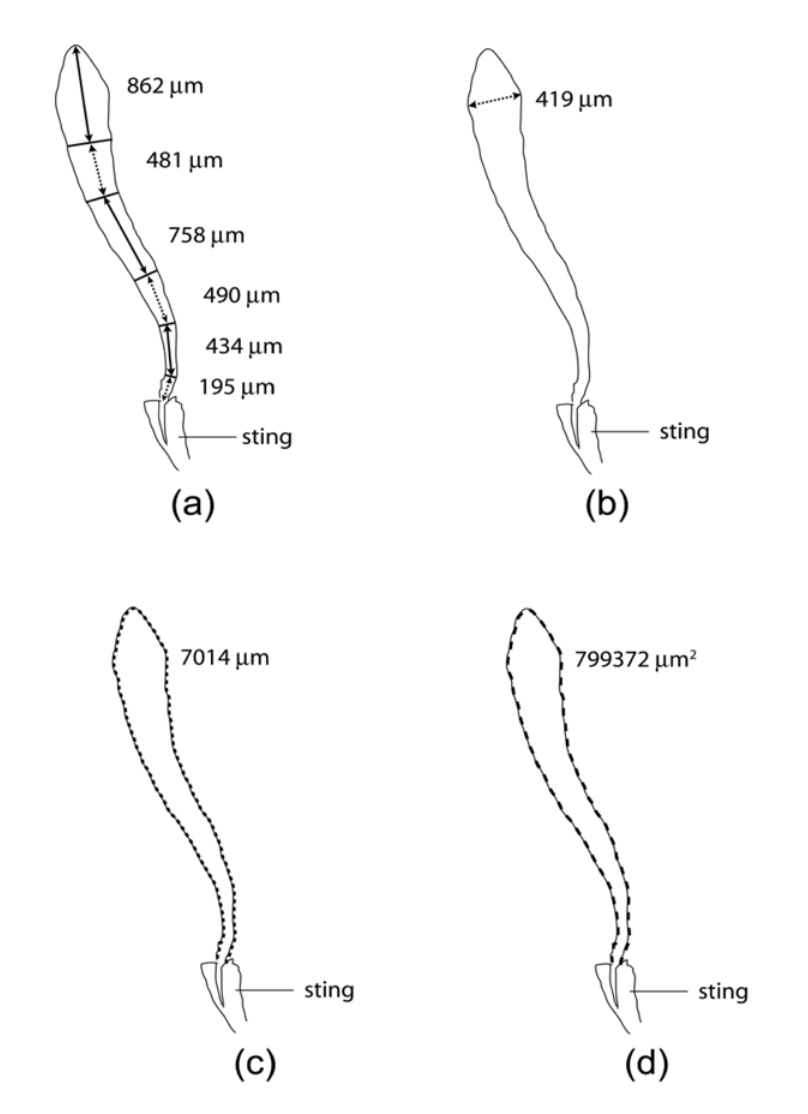
Fig 1: Diagrammatic representation of the measurements made from the image of Dufour’s gland of Ropalidia marginata ; (a): length of the gland (breaking up the length into several short straight-line segments and summing them up), (b): maximum width of the gland, (c): perimeter of the gland’s image, and (d): area covered by the gland’s image. (Diagram made by tracing from photograph, drawing: Aniruddha